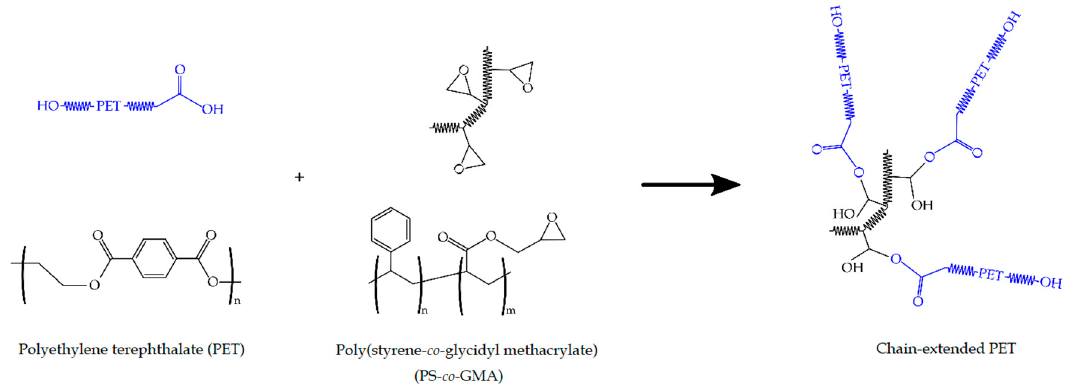
Figure 1. Proposed mechanism of chain extension of polyethylene terephthalate (PET) with poly(styrene- co -glycidyl methacrylate) (PS- co -GMA).